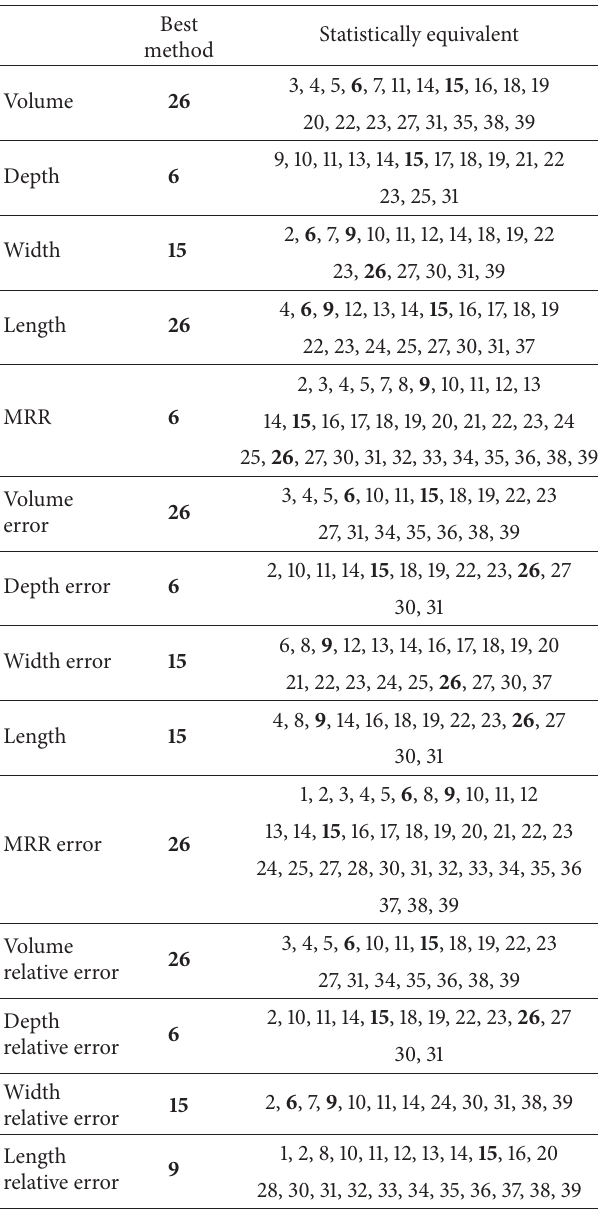
Table 12: Summary table. Table 13: Methods